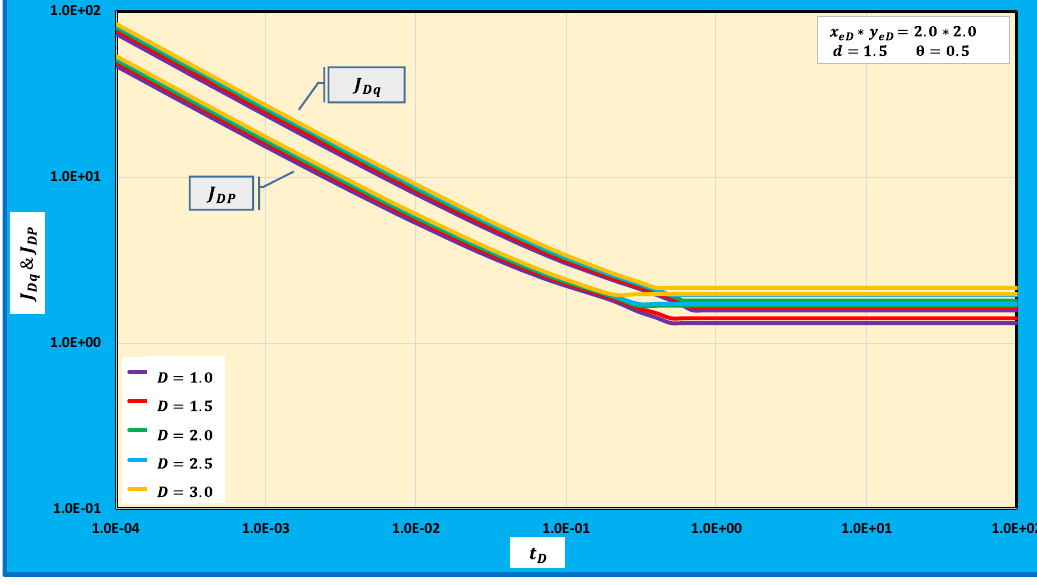
Fig. 18 Productivity index behaviors for different Euclidean dimensions ( 𝜃 = 0.5